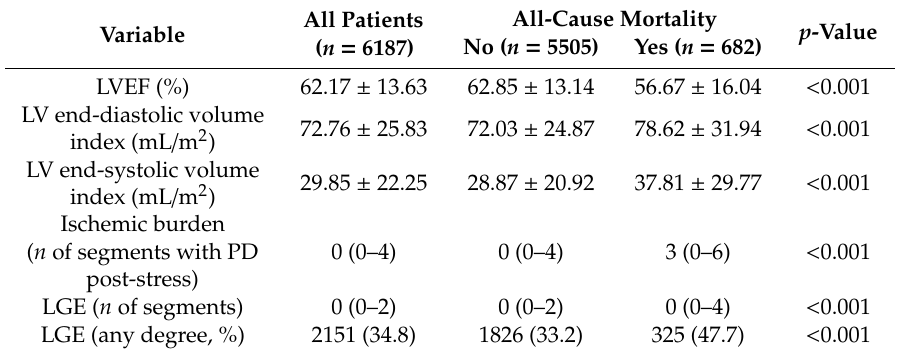
Table 2. CMR characteristics of the whole registry and of patients with and without all-cause